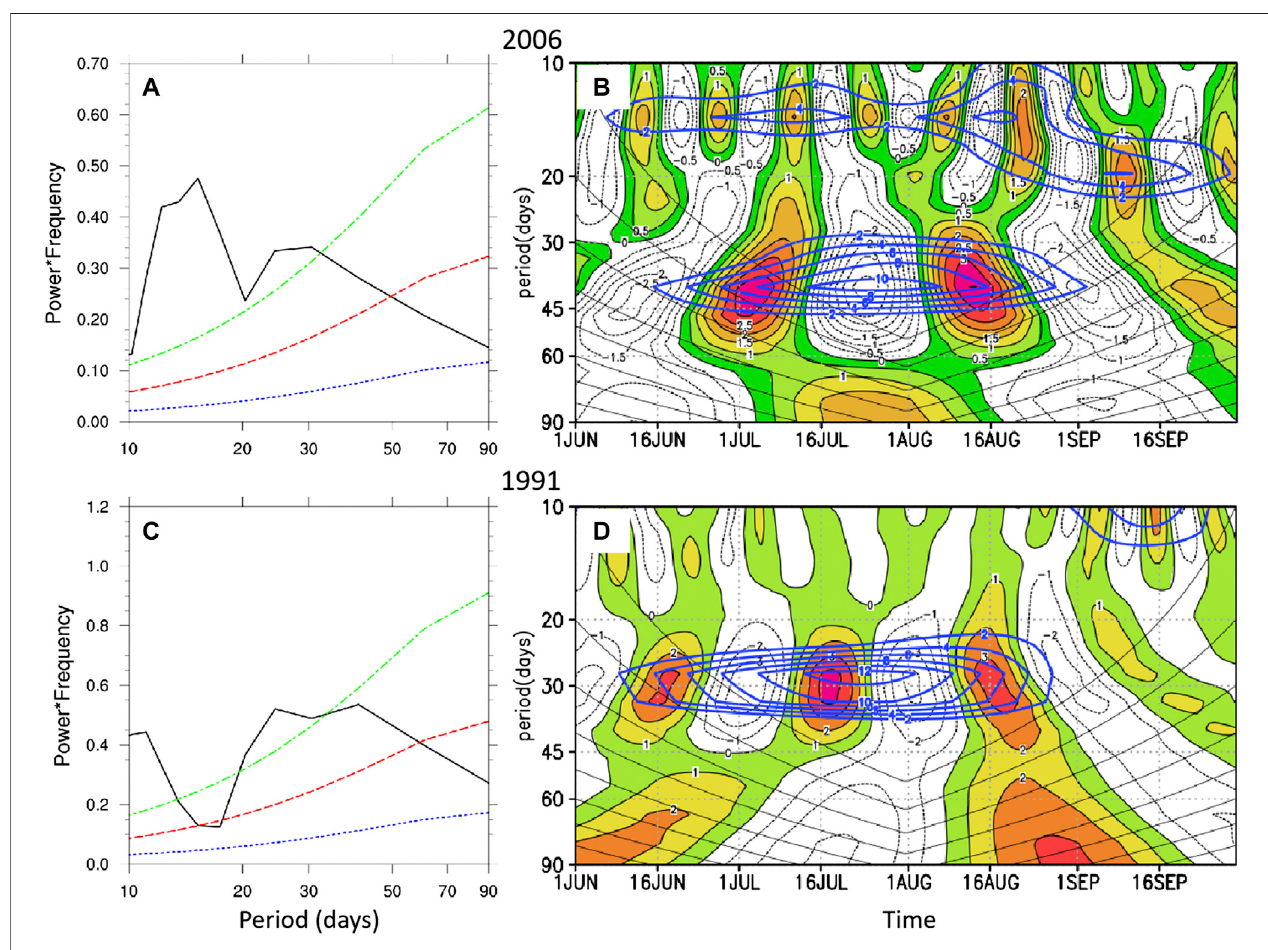
FIGURE 3 | Same for Figure 2 but for year 2006 (A – B) and 1991 (C – D) .